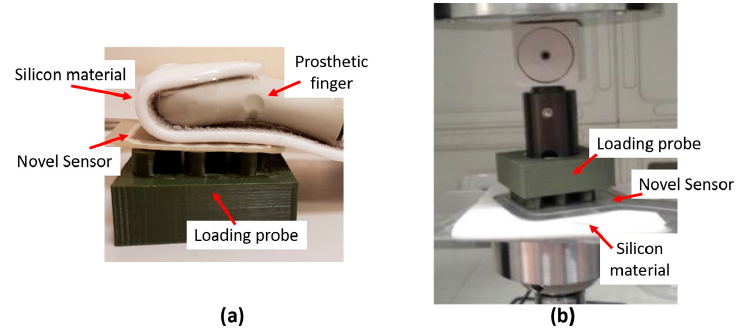
Figure 6. Human-like grasping condition. The real condition ( a ) is mimicked with the setup shown on the right ( b ).